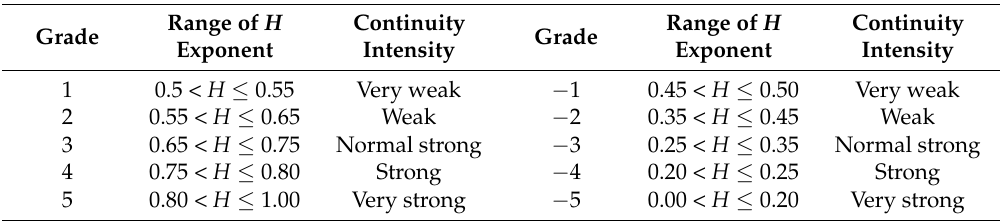
Table 1. Performance characteristics of Hurst exponent and continuity intensity: Grades 1, − 1, fractional Brownian movement; Grades 2, − 1, standard Brownian movement; Grades 3, − 3, 4, −